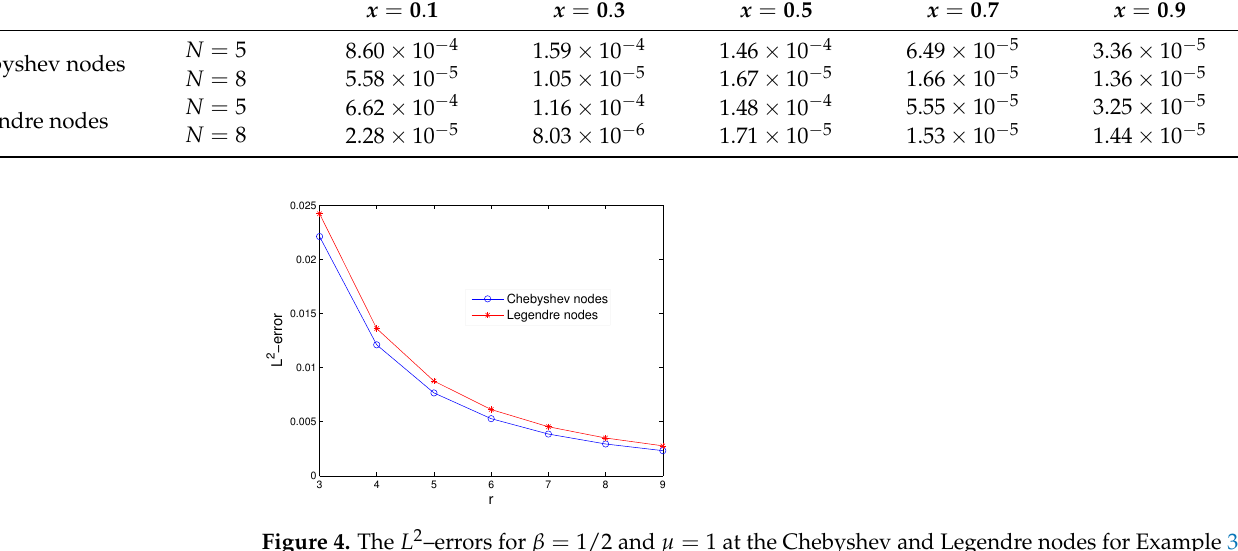
Table 5. The L ∞ –error taking β = 1/3 and µ = 1/3 for Example 3. x = 0 . 1 x = 0 . 3 x = 0 . 5 x = 0 . 7